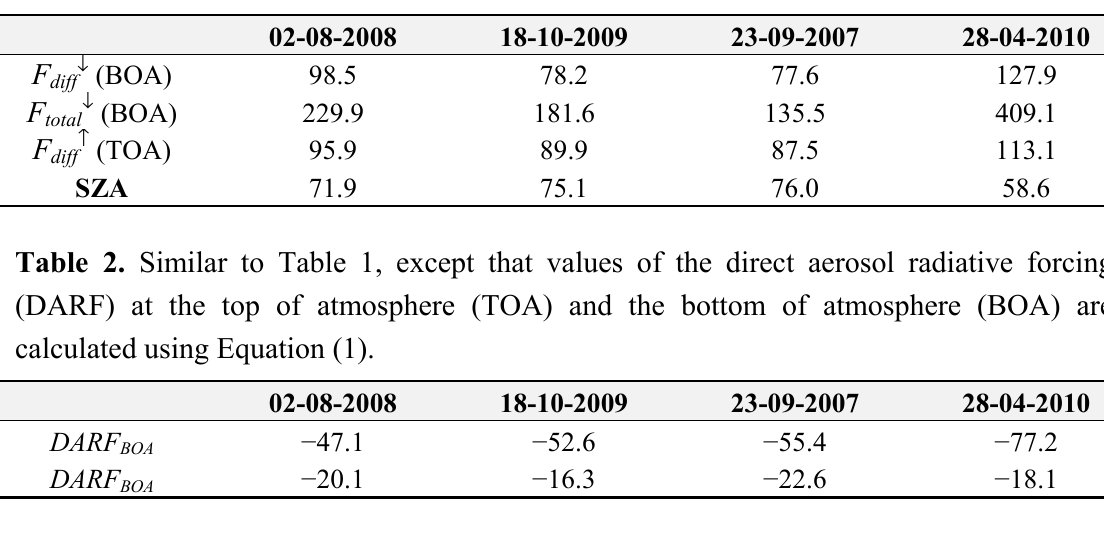
↑ ↓ ), downwelling diffuse ( F ) and diff diff